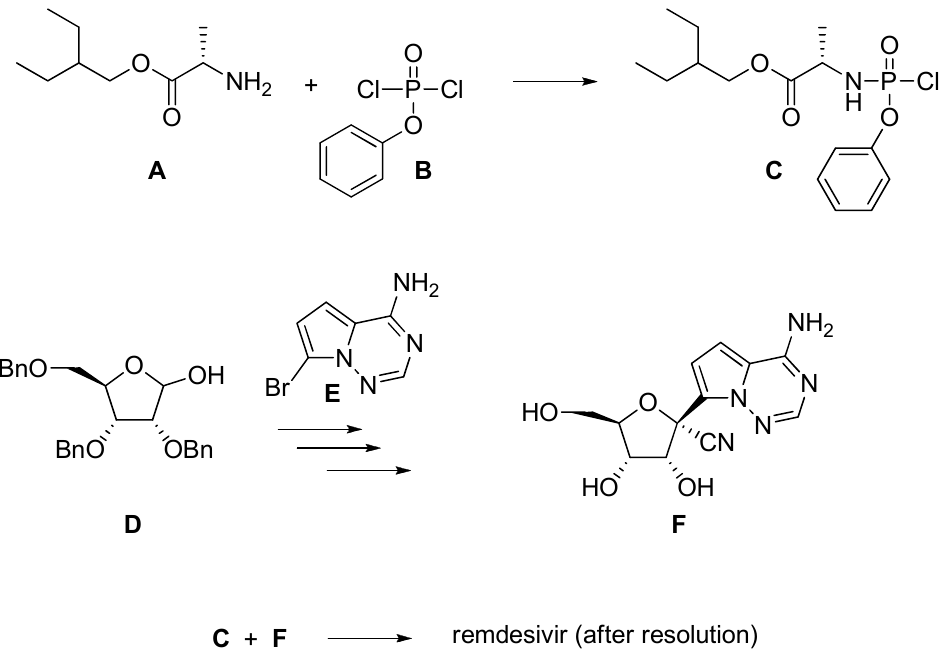
Figure 2. Schematic synthesis of remdesivir ( 1 ). Yields were not mentioned in [20] .